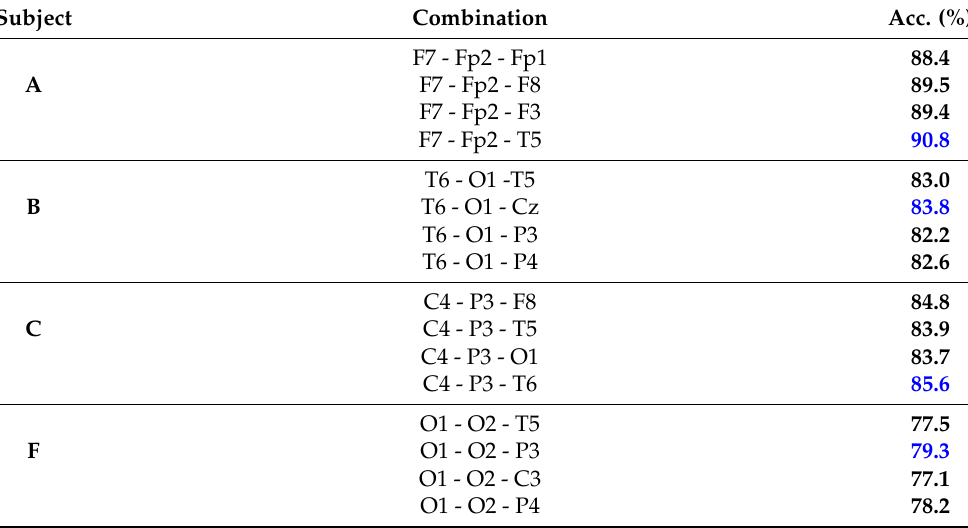
Table 6. Classification accuracies achieved for each 3-channel combination.